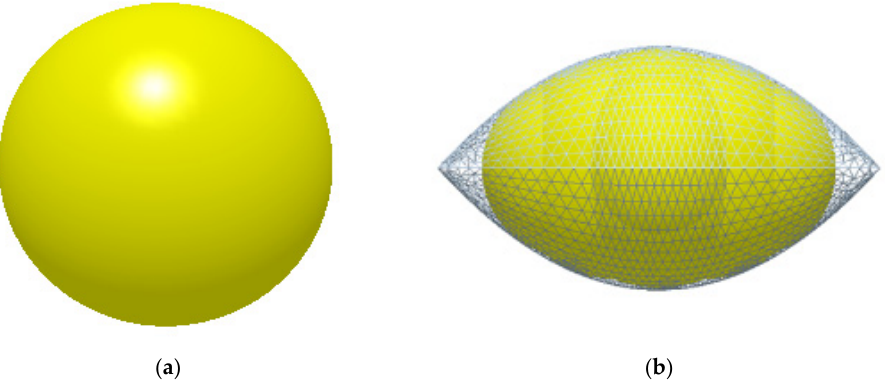
Figure 2. Powder and red clover seed simulation models. ( a ) Powder particles; ( b ) red clover seed pellets.